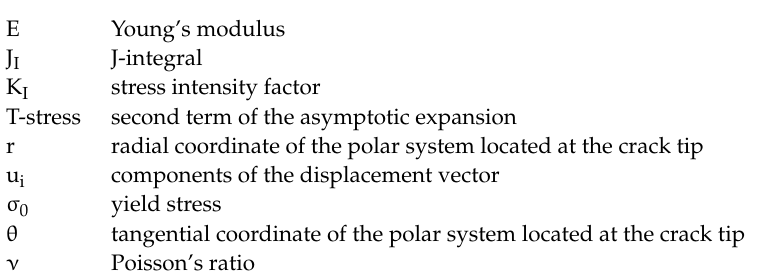
Figure 13. Comparison of plastic zones at the first load maximum for T = 0 σ 0 ( A ), and T = − 0.5 σ 0 ( B Figure 13 . Comparison of plastic zones at the first load maximum for T = 0 σ 0 (A), and T = − 0.5 σ 0 (B).